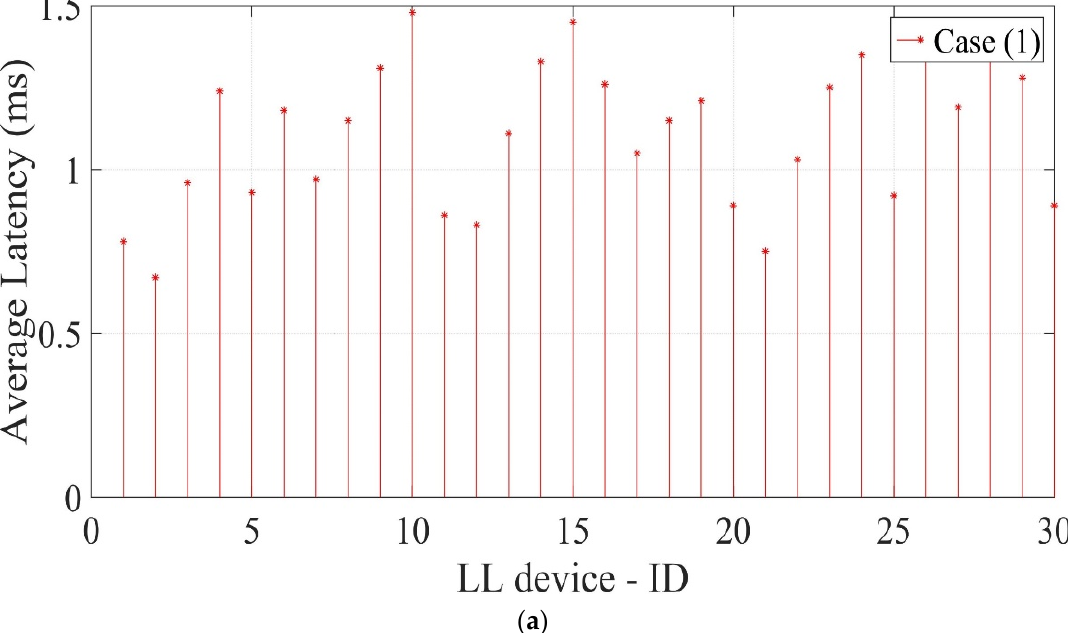
Figure 8. Average latency of handling IoT tasks for the three considered cases of the first scenario. ( a ) Average latency for case (1), ( b ) Average latency for case (2), and ( C ) Average latency for case (3).